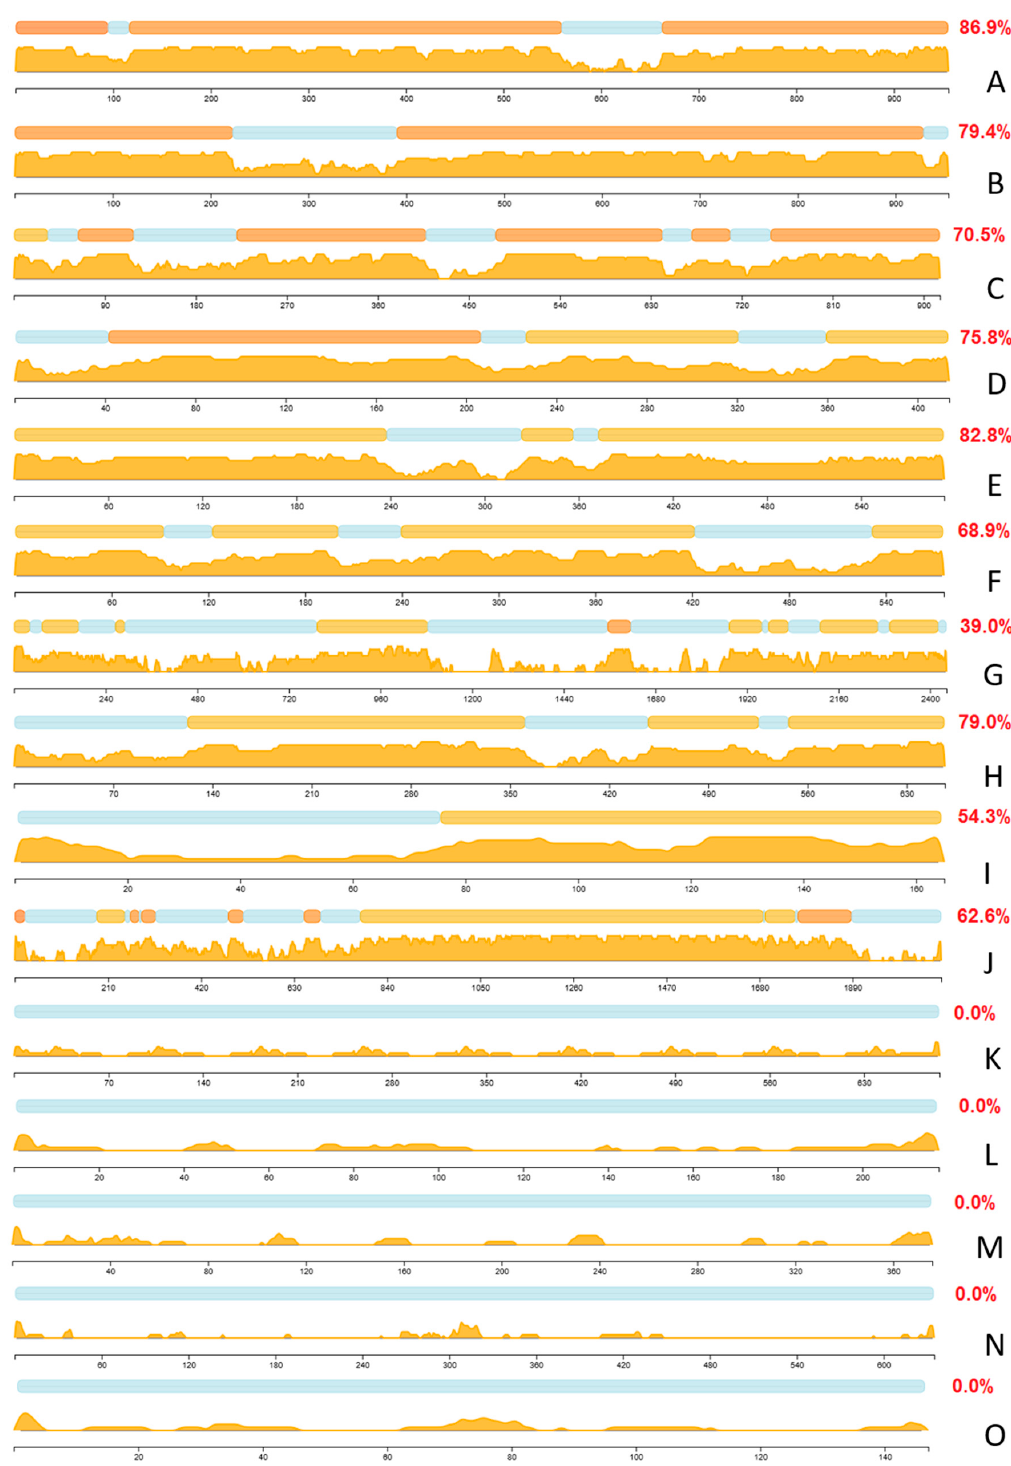
Figure 4. Intrinsic disorder levels in the disordered human hubs characterized by the highest levels of disorder ( A – E ), highly disordered hubs characterized by the highest levels of interactability ( F – J ), and ordered hubs with the highest interactability levels ( K – O ). The disorder was annotated using the MobiDB platform [141–143]; disorder content is shown in red font. Each plot represents disorder tendencies in two forms—by bar plots showing location of IDPRs and by area plots showing sequence distribution of consensus disorder scores evaluated by MobiDB lite disorder predictor [143]. ( A )